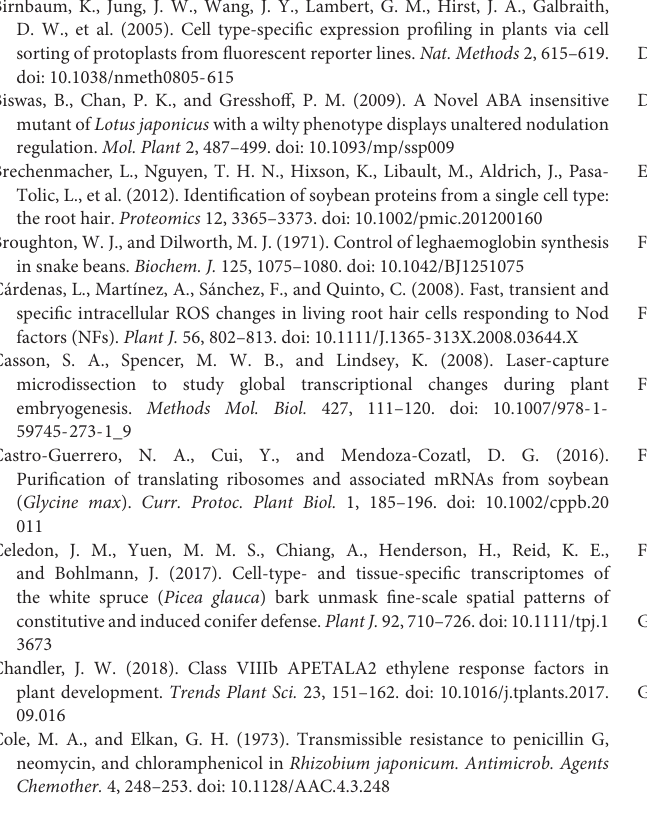
Supplementary Figure 1 | Functional classification and comparison of TRAP-seq DEGs. (A) Biological groups of DEGs categorized according to sequence similarity by MapMan. Functional subcategories of (B) transcription factors and (C) phytohormones comparing between 72 and 96 hpi DEGs. Blue and green bars represent the number of specific and common genes for each time point, respectively. Supplementary Table 1 | Fold change of DEGs in TRAP-seq.